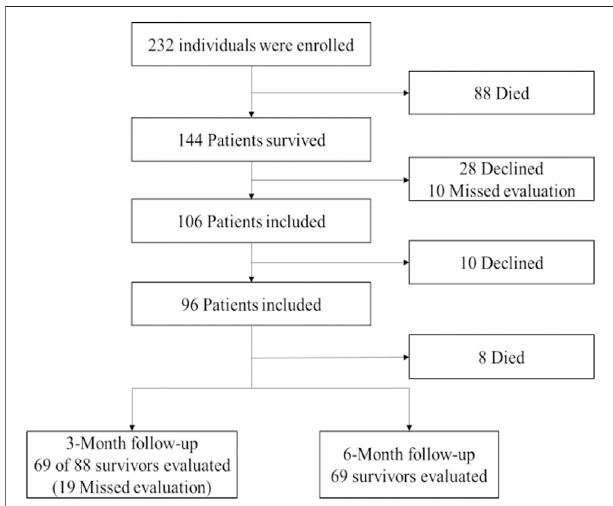
FIGURE 1 | Enrollment of patients and follow-up for the fi rst 6 ° months after